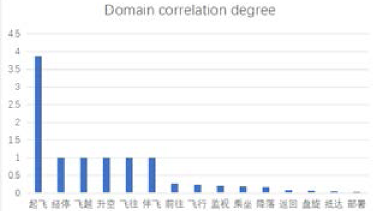
Fig. 4. Trigger words and domain correlation degree.